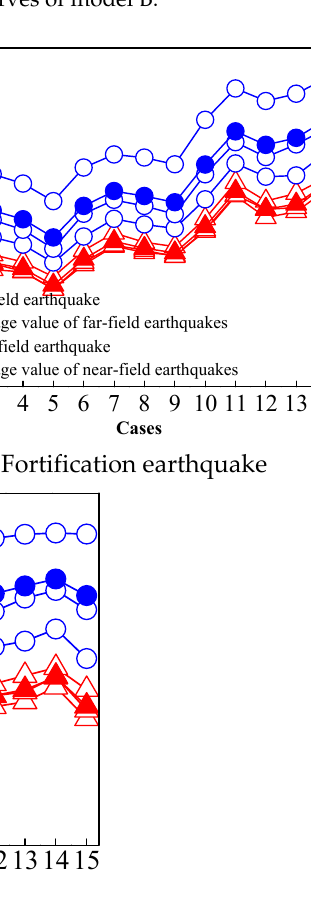
Figure 10. Component vulnerability coefficient curves of model B.